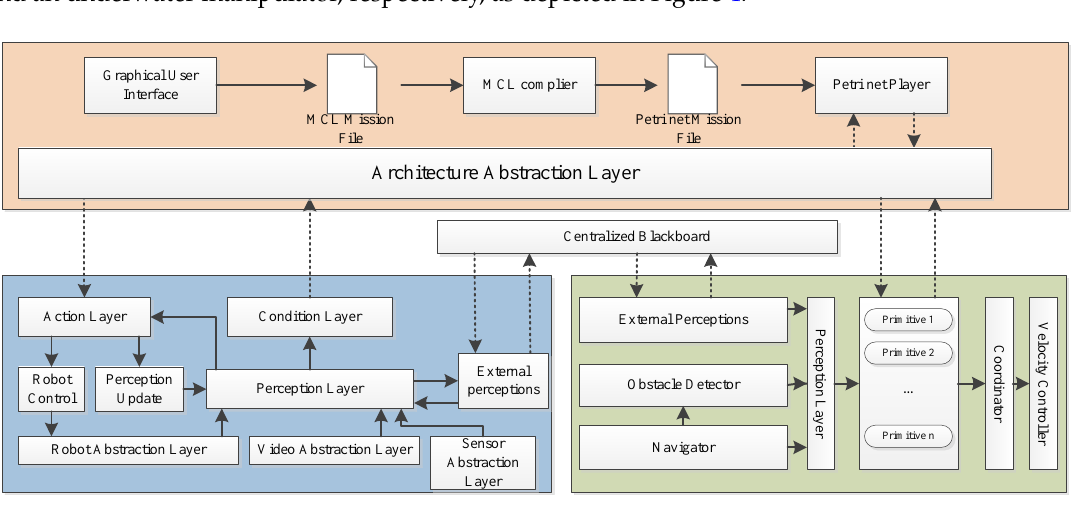
Figure 4. RAUVI architecture, as described in [31].